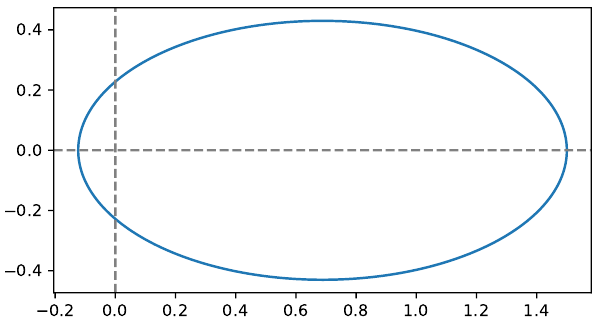
looks like an elliptical orbit, with the central mass at the origin serving as one of the focus points. But we should demonstrate this fact in a more quantitative way. Tak- ing the minimum and maximum x value on our simulated orbit, we find that the left-most point of the orbit is at x = − 0 . 12335823920305192, while the rightmost point is, by construction, at x = 1 . 5 (since that is where we put the initial position of our particle, its velocity pointing straight